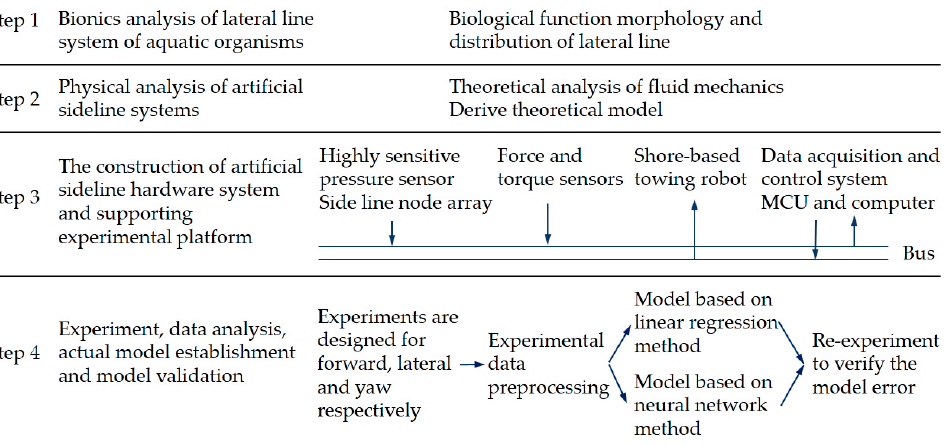
Figure 1. Main content and order of this paper.